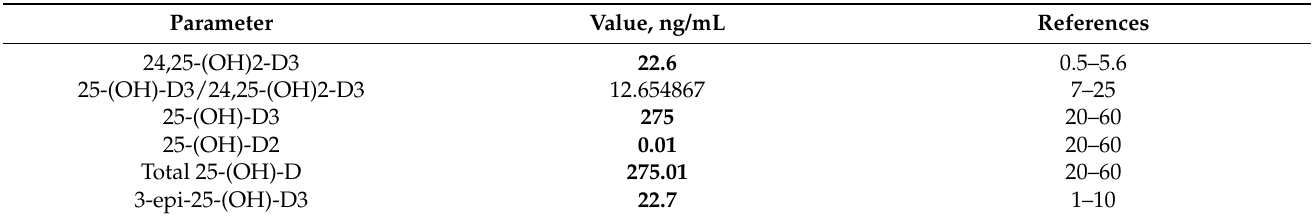
Table 3. Results of vitamin D metabolites in the patient’s blood serum